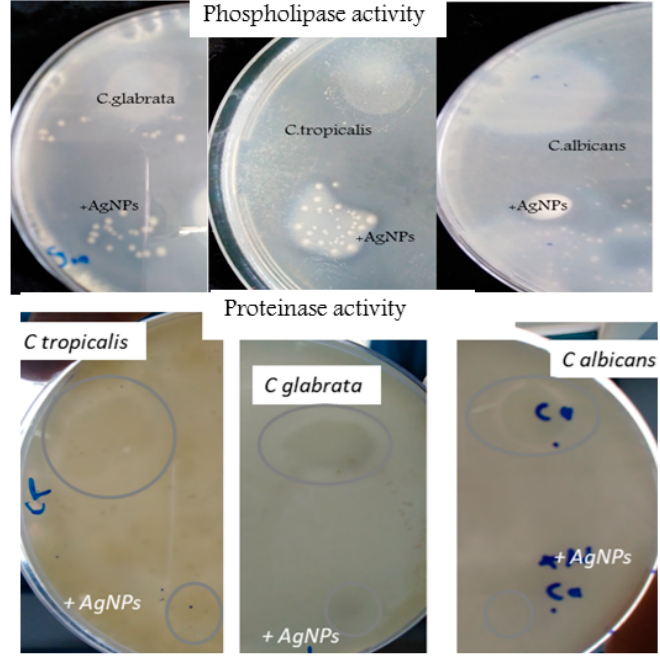
Figure 8. Comparative activities of phospholipase and proteinase produced by Candida species: C. albicans , C. tropicalis , C. glabrata in the absence and in the presence of AgNPs (+AgNPs). The observation of a clear zone around the Candida colony confirms the enzyme production.